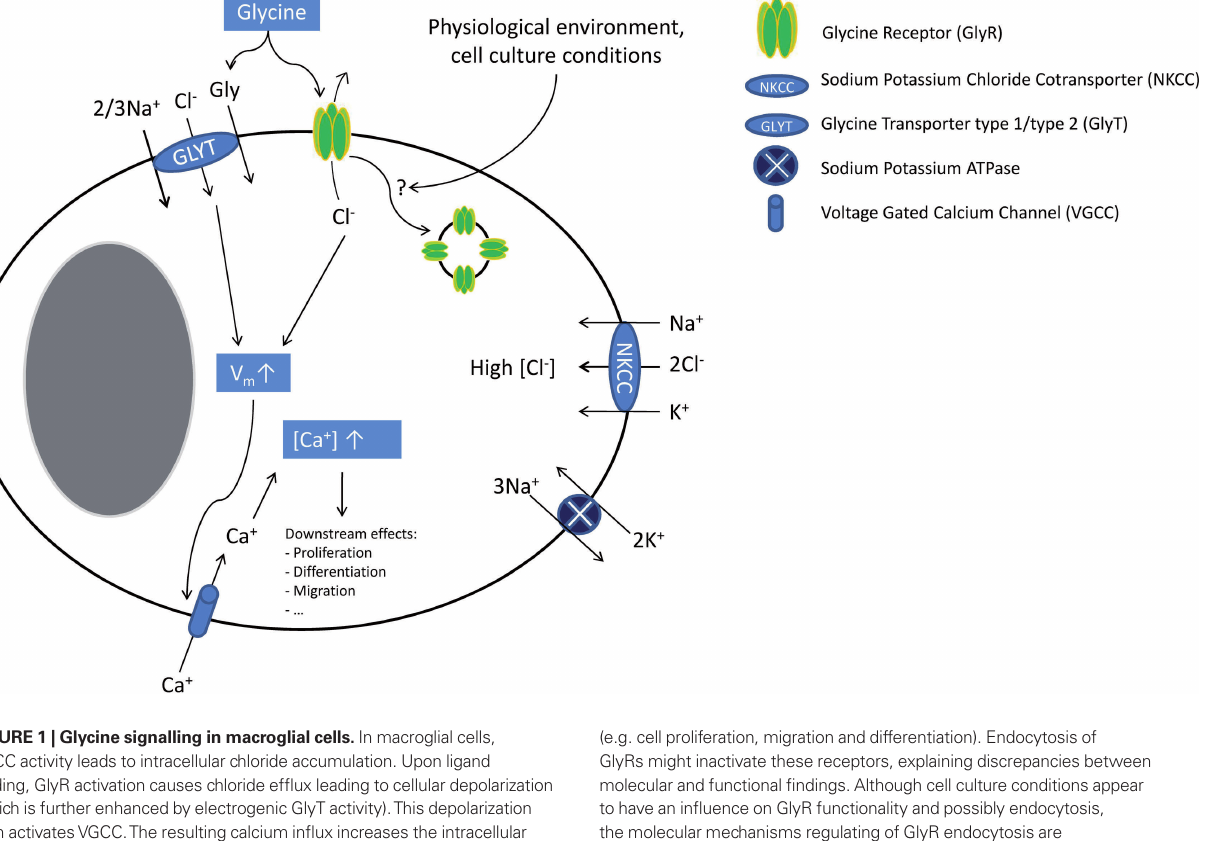
(e.g. cell proliferation, migration and differentiation). Endocytosis of GlyRs might inactivate these receptors, explaining discrepancies between molecular and functional fi ndings. Although cell culture conditions appear to have an infl uence on GlyR functionality and possibly endocytosis, the molecular mechanisms regulating of GlyR endocytosis are